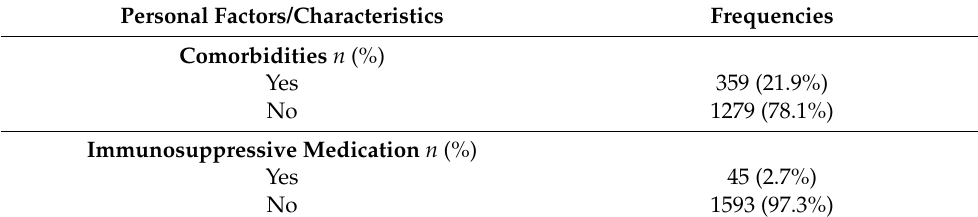
Table 1. Cont. Personal